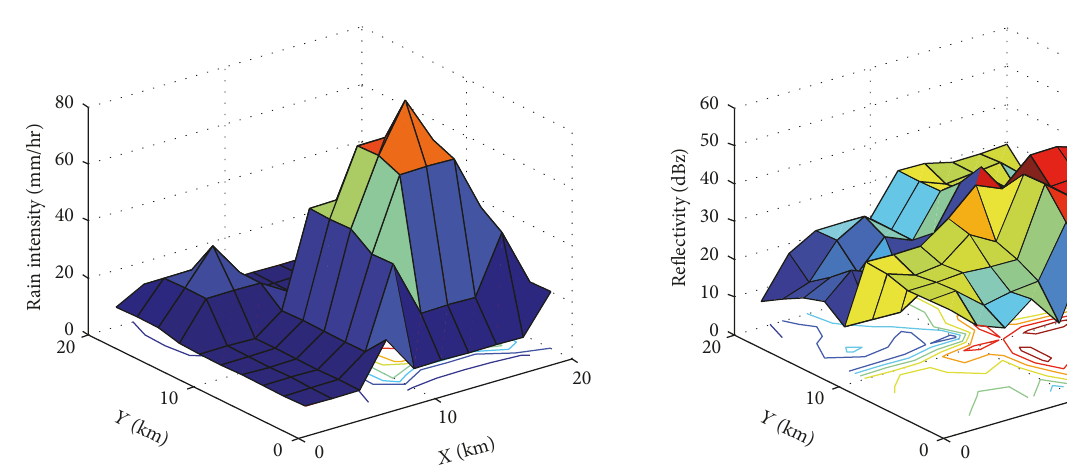
Figure 5: Initial field of rainfall intensity in the simulation area.